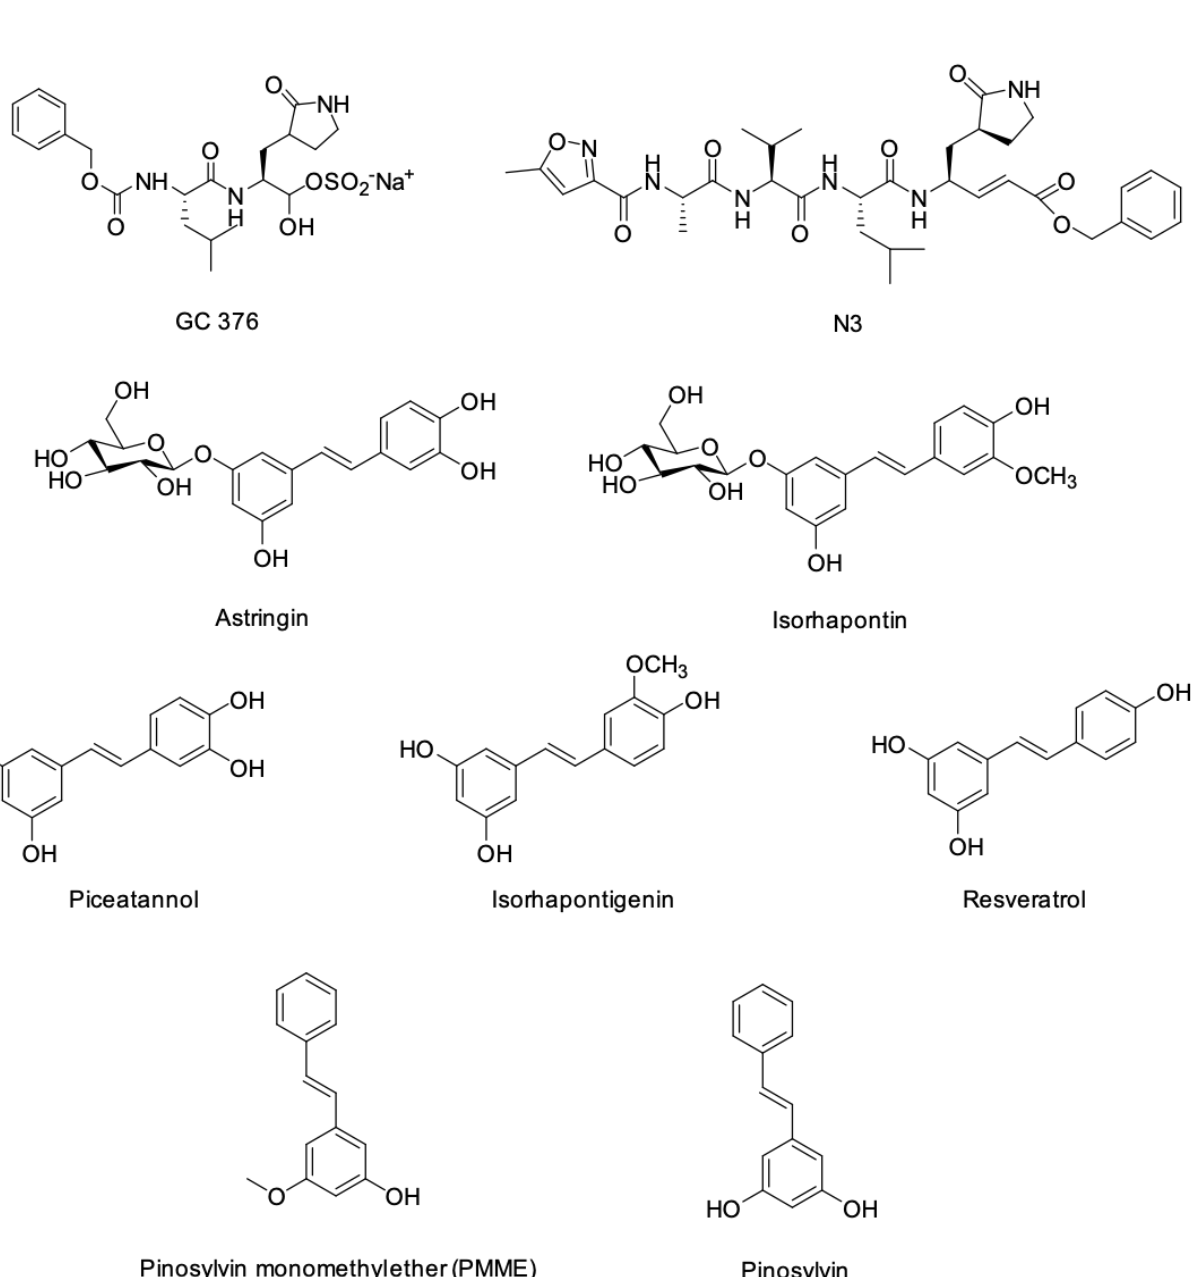
Figure 1. Structures of the reference and stilbene ligands used for the molecular docking studies against M pro .